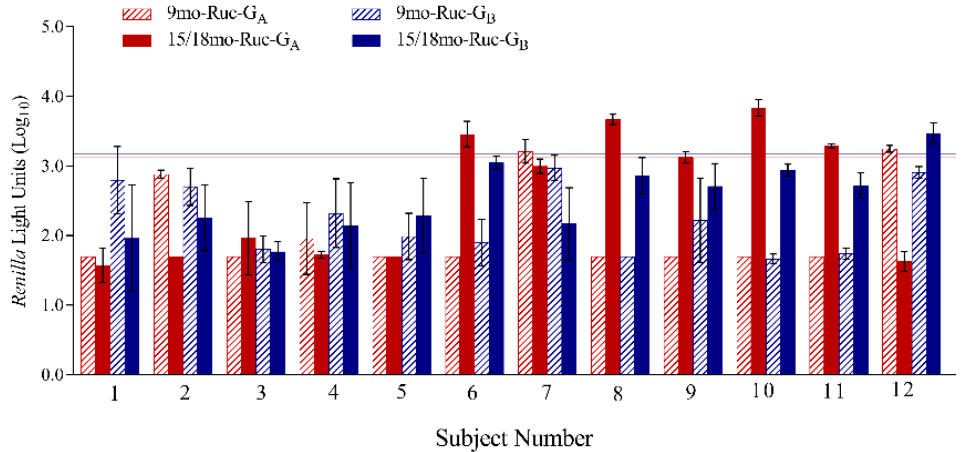
Figure 8. Twelve paired serum samples obtained at 9 and 15/18 months of age were tested against Ruc-G A and Ruc-G B antigens. The mean reactivities for individual samples tested against Ruc-G A and Ruc-G B antigens are shown in red and blue bars, respectively, and error bars represent standard deviations. Cutoff values for a positive signal were five standard deviations above the mean value of the negative control and are shown as horizontal red (Ruc-G A ) and blue lines (Ruc-G B ).